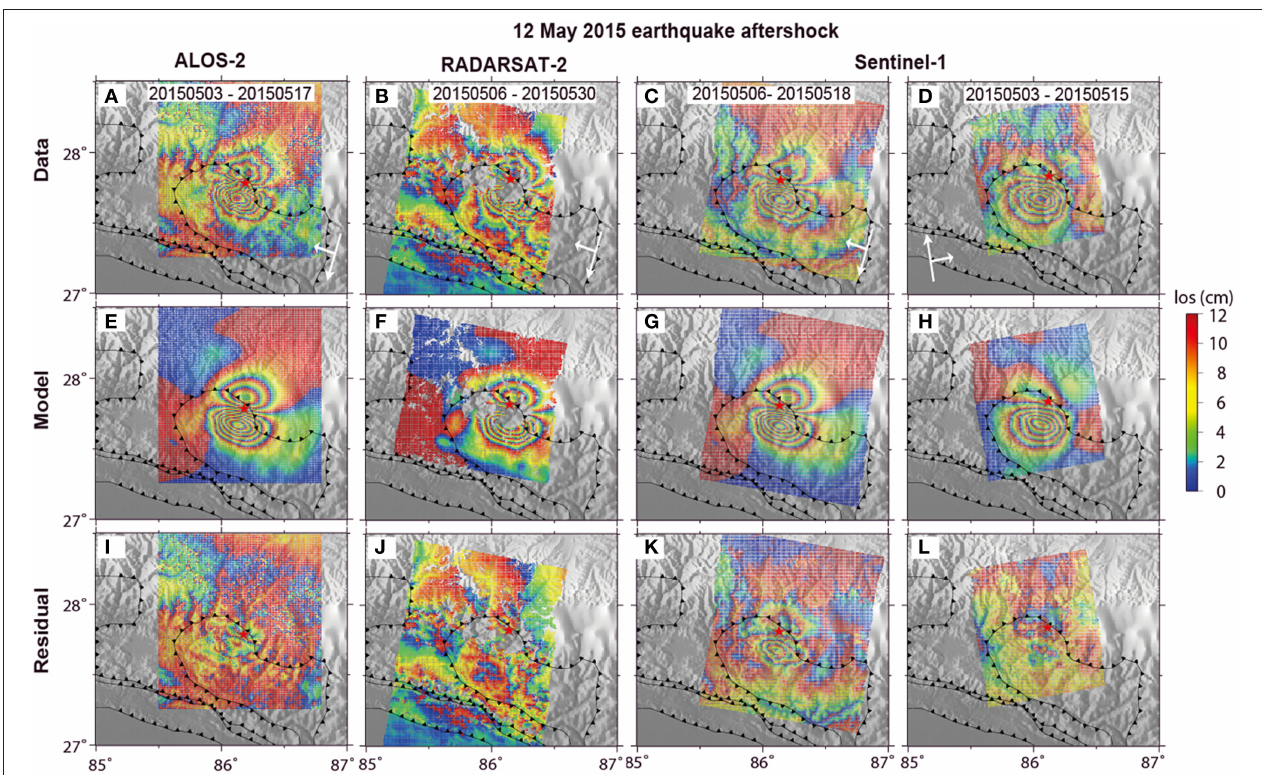
FIGURE 3 | Largest recorded earthquake aftershock, as seen from radar satellites, LOS as indicated by white arrow in (A–D). Upper row is the data ( A , wideswath ALOS-2; B , RADARSAT-2; and C,D , Sentinel-1 from ascending and descending views). Center row (E–H) is the model solution. Bottom row (I–L) shows the residual after subtracting the model from the data. Red star depicts the location of the aftershock epicenter, located to the west of the main deformation area. Fault lines are the MFT, MBT, and MCT from south to north, after (Webb et al., 2011). Kathmandu is shown by black circle. This figure is drawn using GMT software.